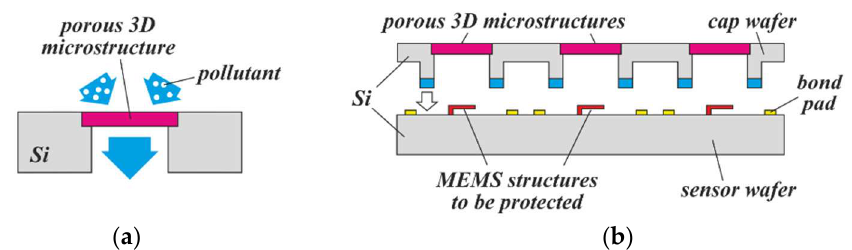
Figure 21. ( a ) Concept of an environmental protection cap for gas sensors, which must communicate with the environment, but degrades if contaminated with particles or moisture; ( b ) illustration of their integration with sensors by wafer-level packaging.